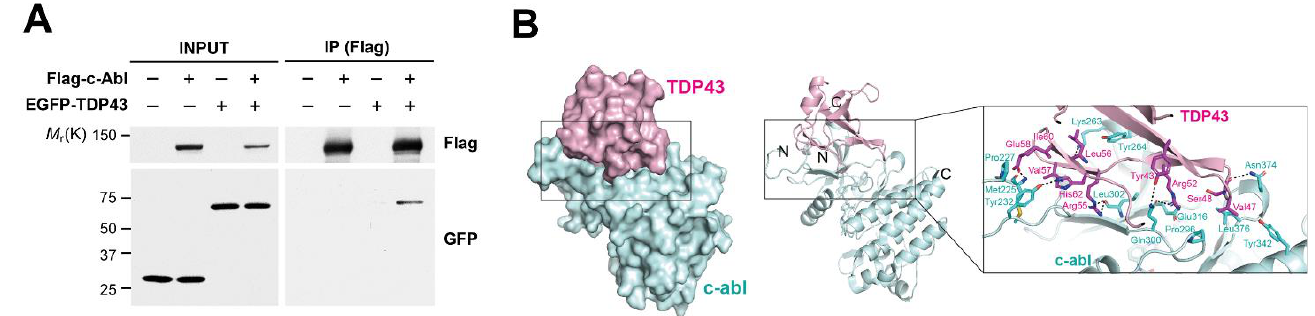
Figure 2. c-Abl interacts with TDP-43. ( A ) Co-immunoprecipitation experiments in SH-SY5Y cells co-transfected with Flag-c-Abl and EGFP-TDP-43. ( B ) The docking model for TDP-43 (red) interacting with c-Abl (cyan). Potential hydrogen bonds are shown as dashed lines.